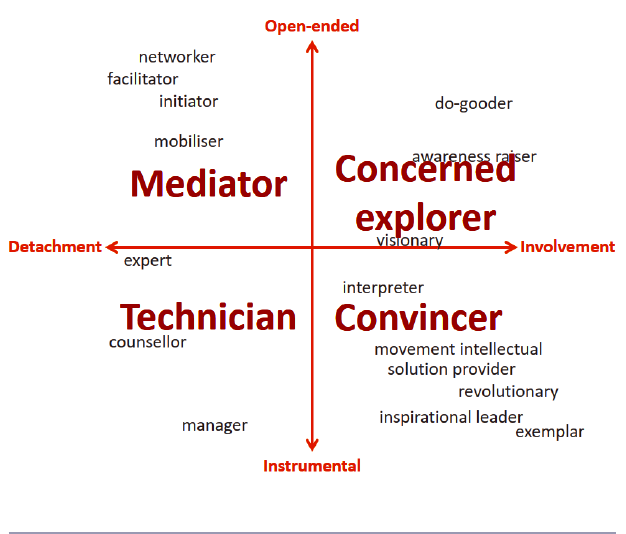
Fig. 2. Ideal typology of change